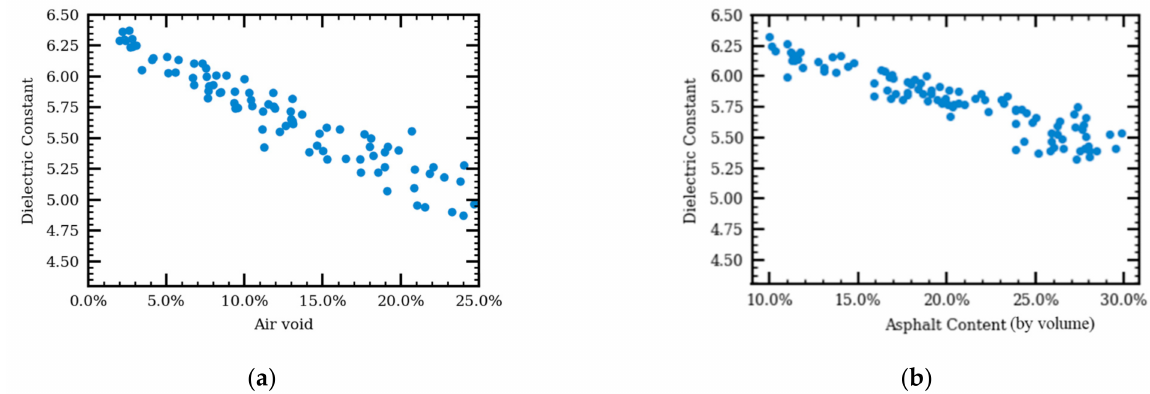
Figure 9. The relationship between dielectric constant and air void ( a ) and the relationship between dielectric constant and asphalt content ( b ).